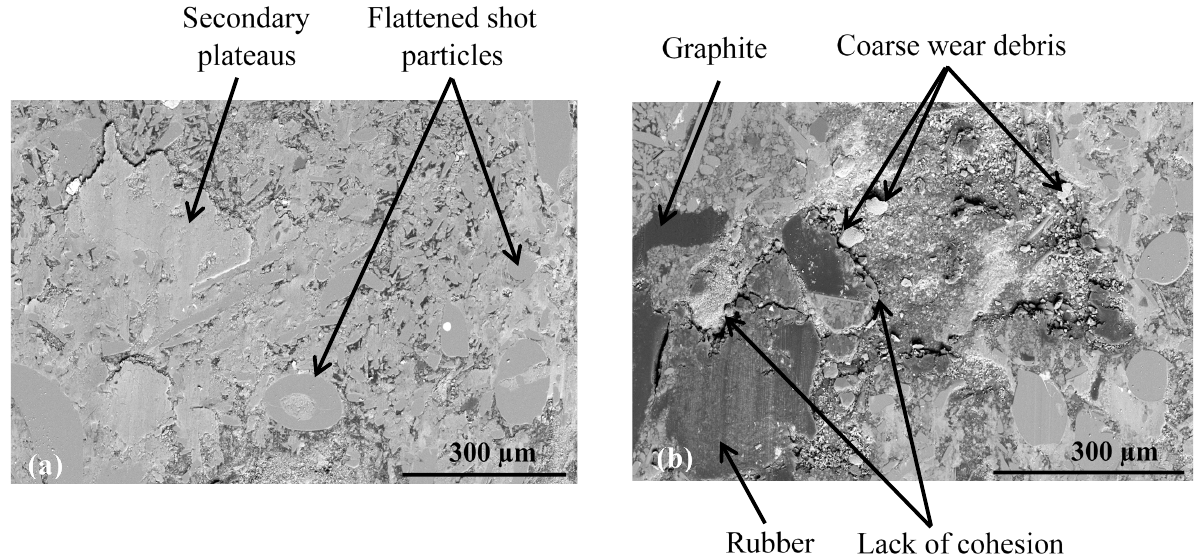
Figure 16. SEM observations of the third body distribution of materials ( a ) M1 and ( b ) M2 (BSE).